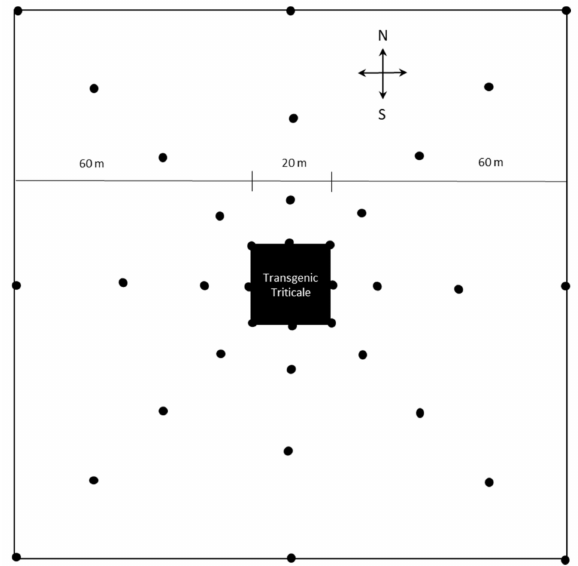
Figure 1. Schematic representation of experimental fields. Black dots represent the location of passive pollen traps. In ‘border rows’ variant the transgenic triticale was sown in the middle (black square, 20 m × 20 m) and it was surrounded by non-transgenic winter triticale cv. Bogo. In ‘spatial isolation’ variant the transgenic triticale was sown in the middle but it was surrounded by an empty field.